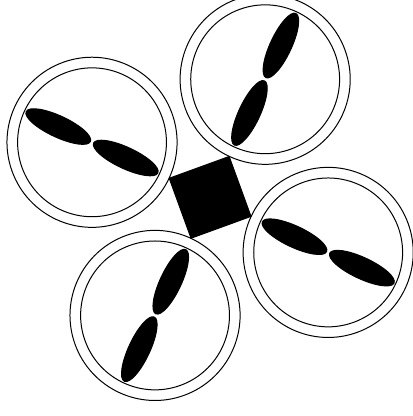
Figure 2. A schematic quadrotor.